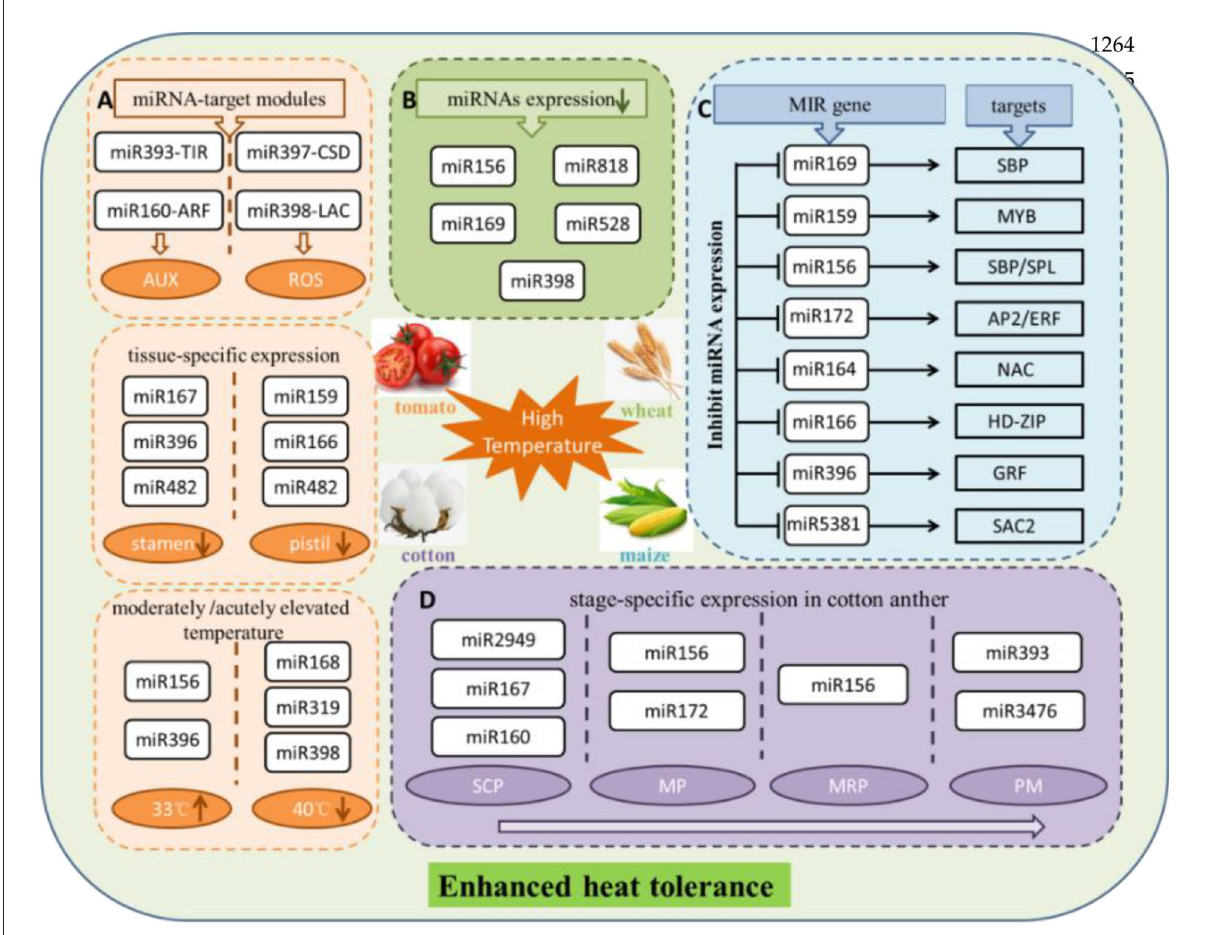
FIGURE2 Schematic diagram exhibited that multiple miRNAs in response to high-temperature stress in several plants. (A) MiRNAs display tissue-specific expression under heat stress in tomato and through regulating different metabolic pathways to resist high temperature. Also, miRNAs expression is affected by moderately or acutely elevated temperature. (B) Certain miRNAs are showed downregulated expression suffered heat treatment in wheat. (C) Effect on expression of miRNAs and their corresponding targets under heat surrounding conditions in maize. (D) MiRNAs show specific expression in critical developmental period of cotton anther to adapt to high-temperature stress. SCP, sporogenous cell proliferation stage; MP, meiotic phase stage; MRP, microspore release period; PM, pollen maturity stage. miRNAs upregulated expression and downregulated expression are represented by upward and downward arrows in the circle, respectively. AUX, auxin; ROS, reactive oxygen species; MYB, MYB proto-oncogene transcription factor; SBP/SPL, SQUAMOSA promoter-binding proteins; AP2/ERF, ethylene response factor; NAC, NAM, ATAF and CUC (NAC) transcription factors; HD-ZIP, zipper motif (LZ) immediately downstream of the home domain; GRF, growth-regulating factor1; SAC2, adenylate